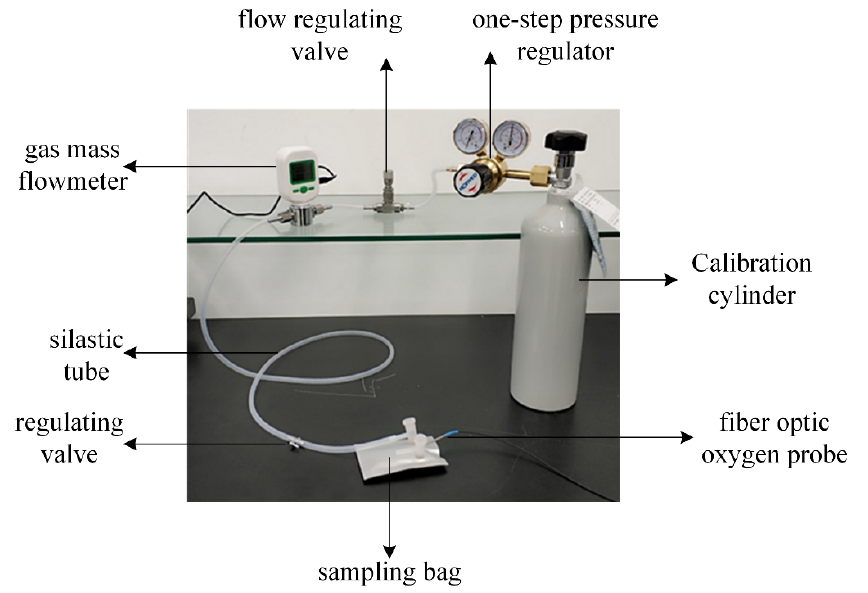
Figure 10. Air connection diagram.